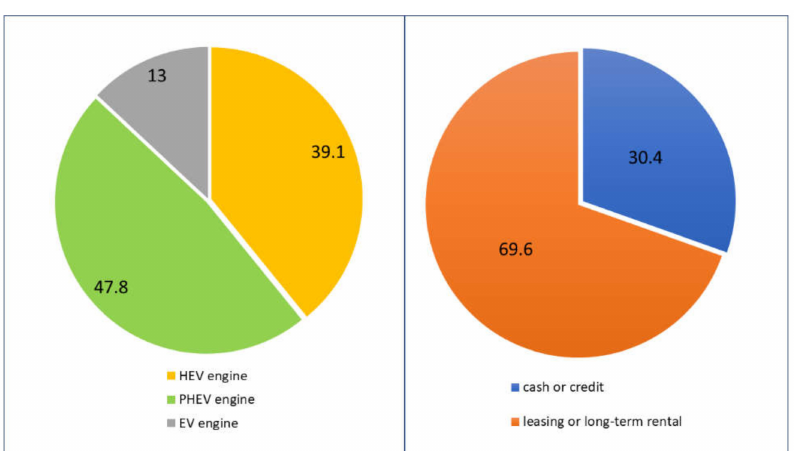
Figure 9. Declaration of individual respondents regarding the purchase of an alternative drive the hypothetical car and its financing during the COVID-19 pandemic (N =